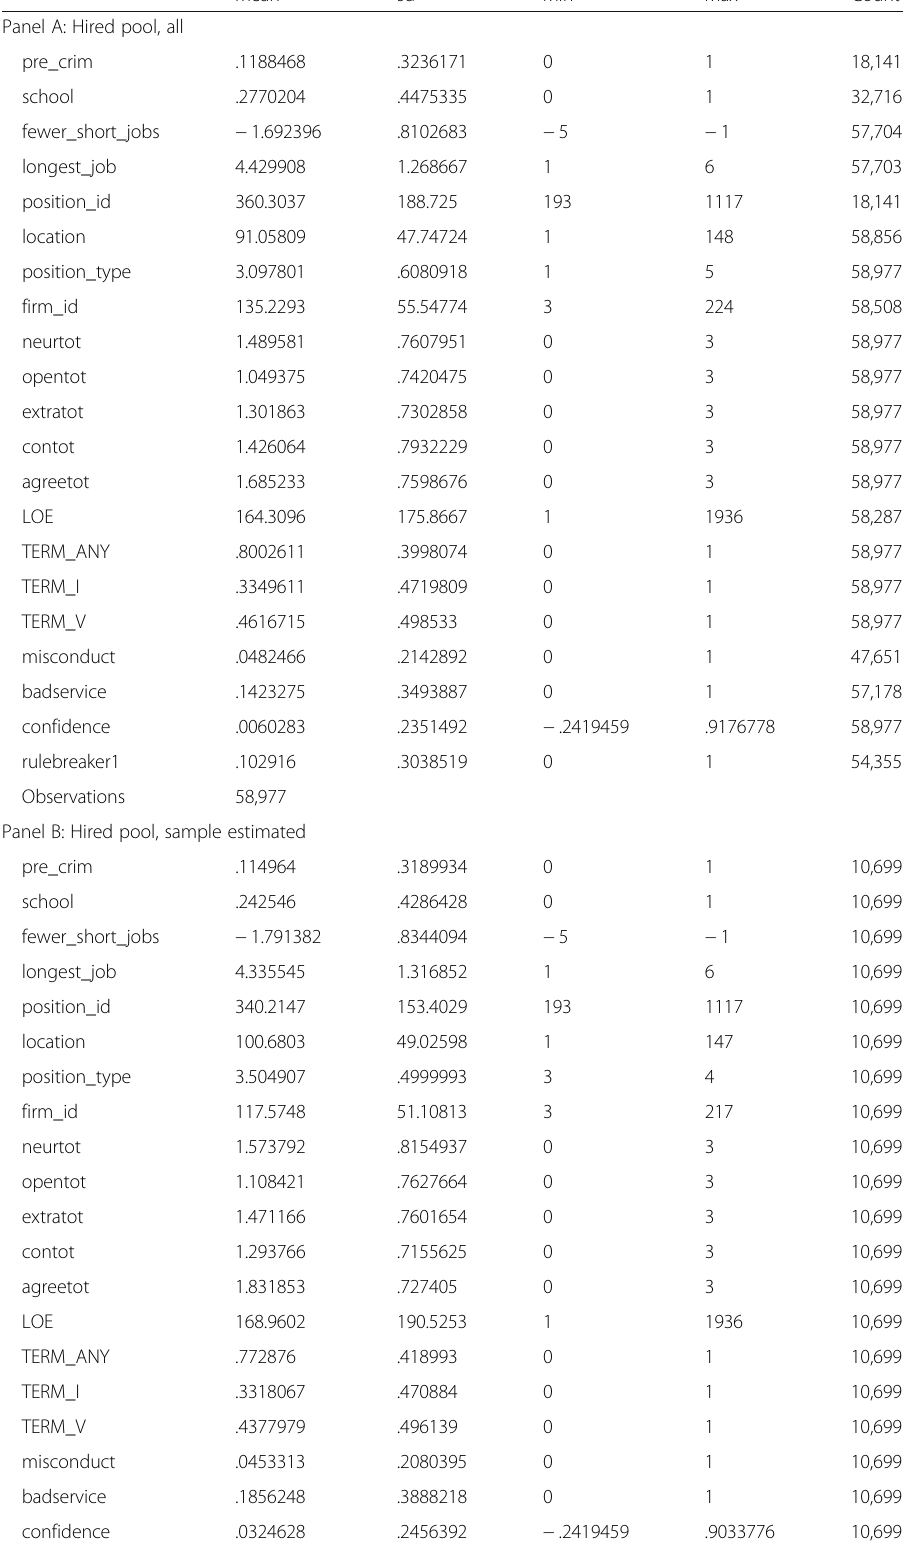
Table 2 Summary statistics for the hired